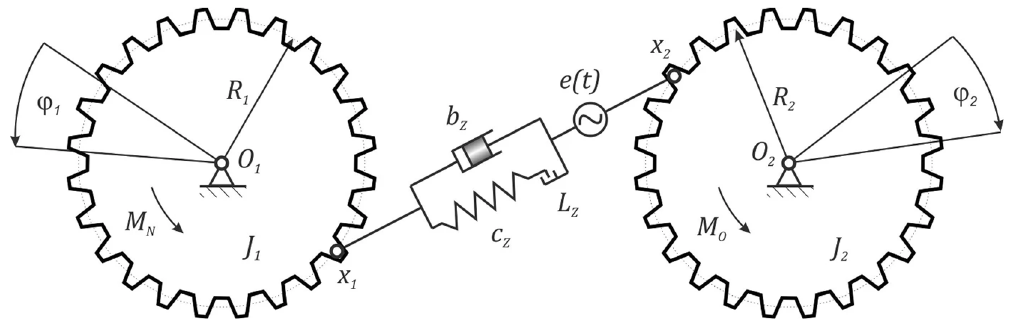
Figure 4. Schematic diagram of gear